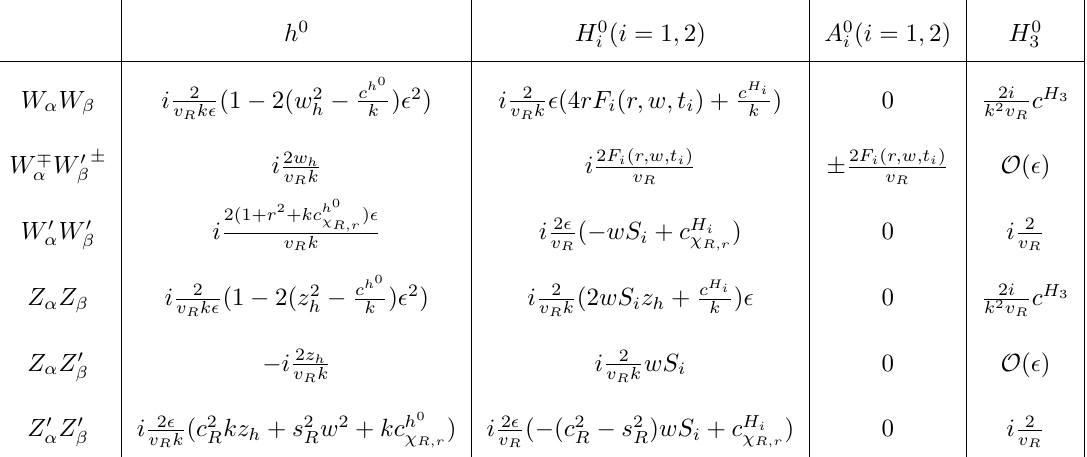
which are not needed are 3